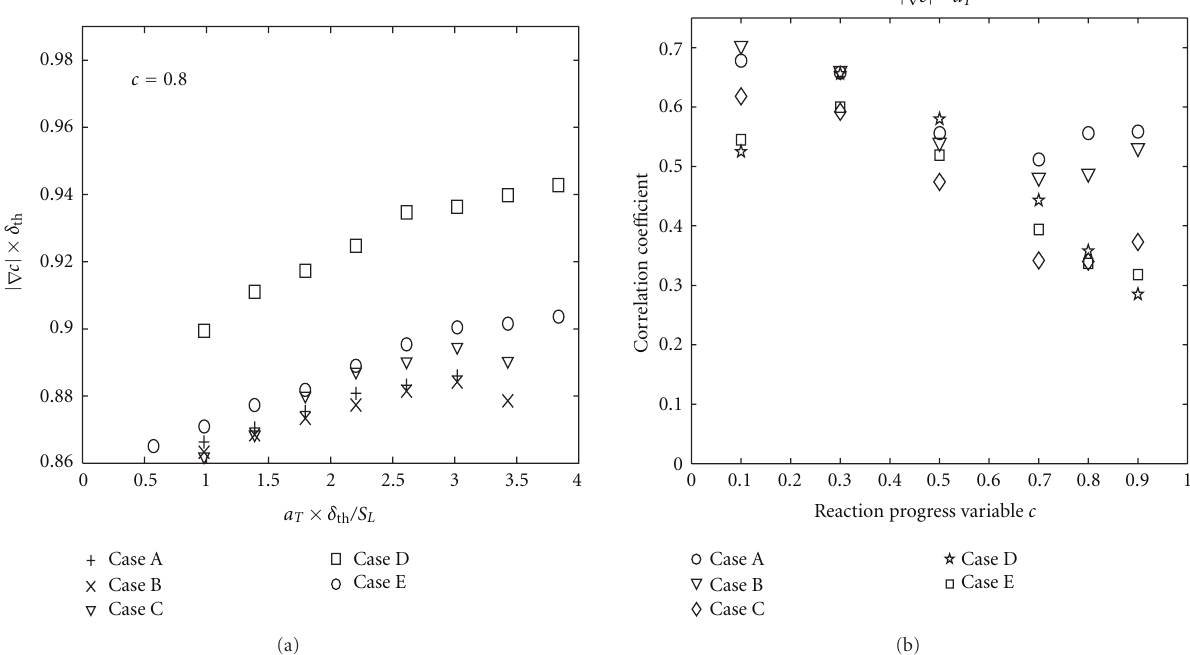
Figure 5: (a) Variation of mean values of |∇ c |× δ th conditional on normalised tangential strain rate a T × δ th /S L for the isosurface at c = 0.8. (b) Variation of the correlation coe ffi cients between |∇ c | and a T on the isosurfaces at c = 0.1 to 0.9 for all cases.